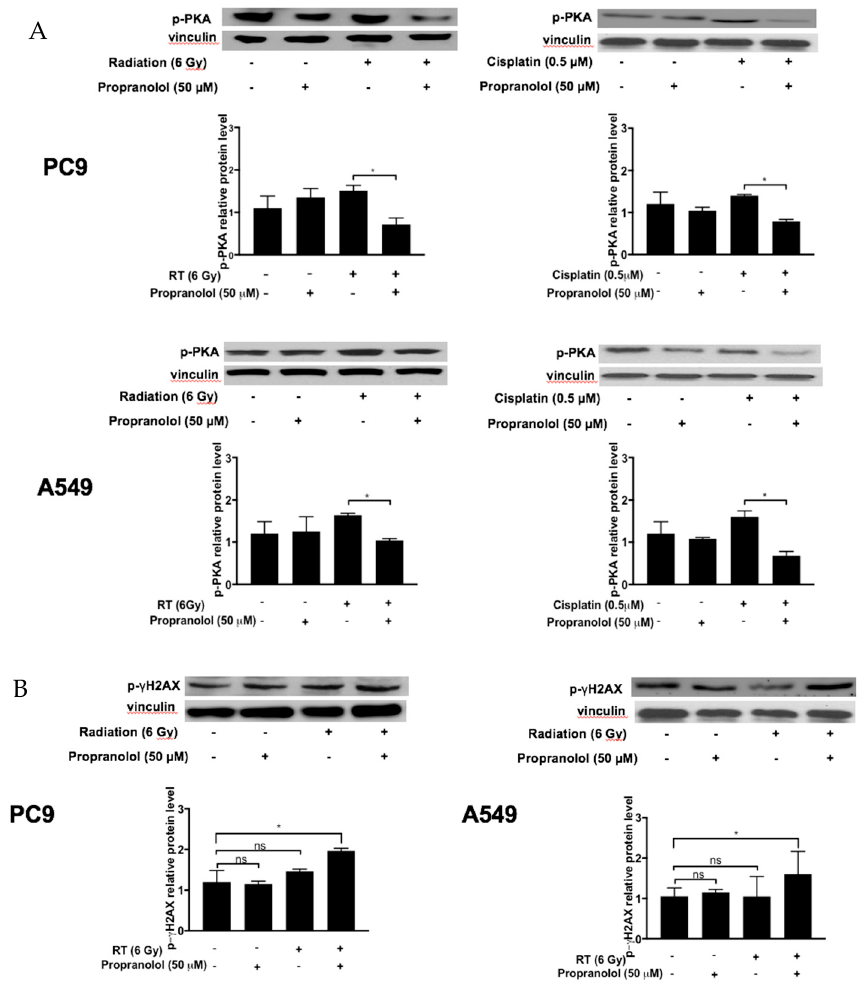
Figure 2. Effect of propranolol on protein kinase A (PKA) and gamma nucleosome core histone H2A ( γ H2AX) protein expression. PC9 and A549 lung cancer cells were treated with / without propranolol (50 µ M) 8 h prior to irradiation (RT) (6 Gy) or cisplatin (0.5 µ M) treatment. The protein levels of phospho-PKA (p-PKA) ( A ) and phospho-gamma nucleosome core histone H2A (p- γ H2AX) ( B ) were analyzed by Western blot. * p <0.05.